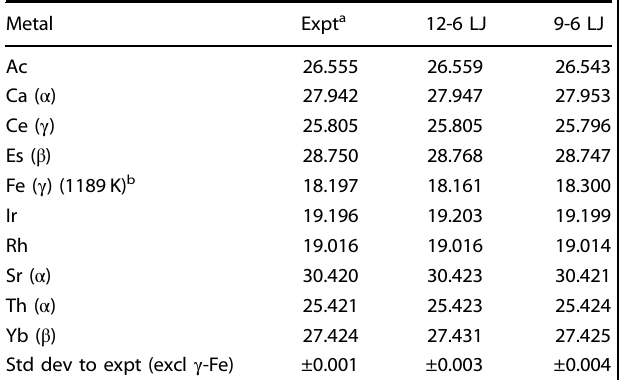
Table 2. Lattice parameters for (5 × a ) 3 fcc supercells according to X- ray diffraction data from experiments and molecular dynamics simulations at 298 K and atmospheric pressure in the NPT ensemble (in Å).